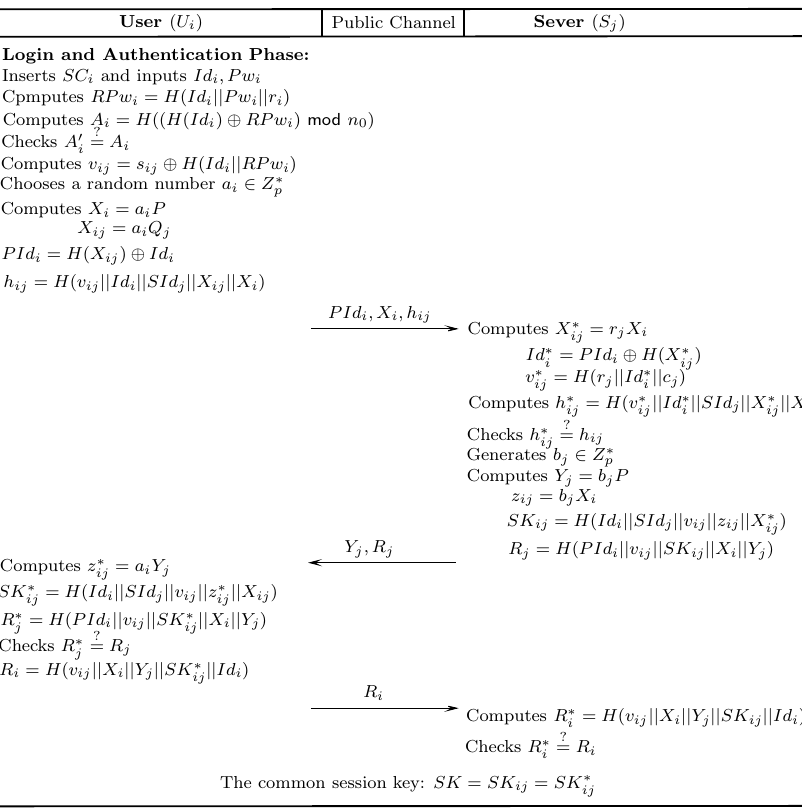
Figure 3. User registration.